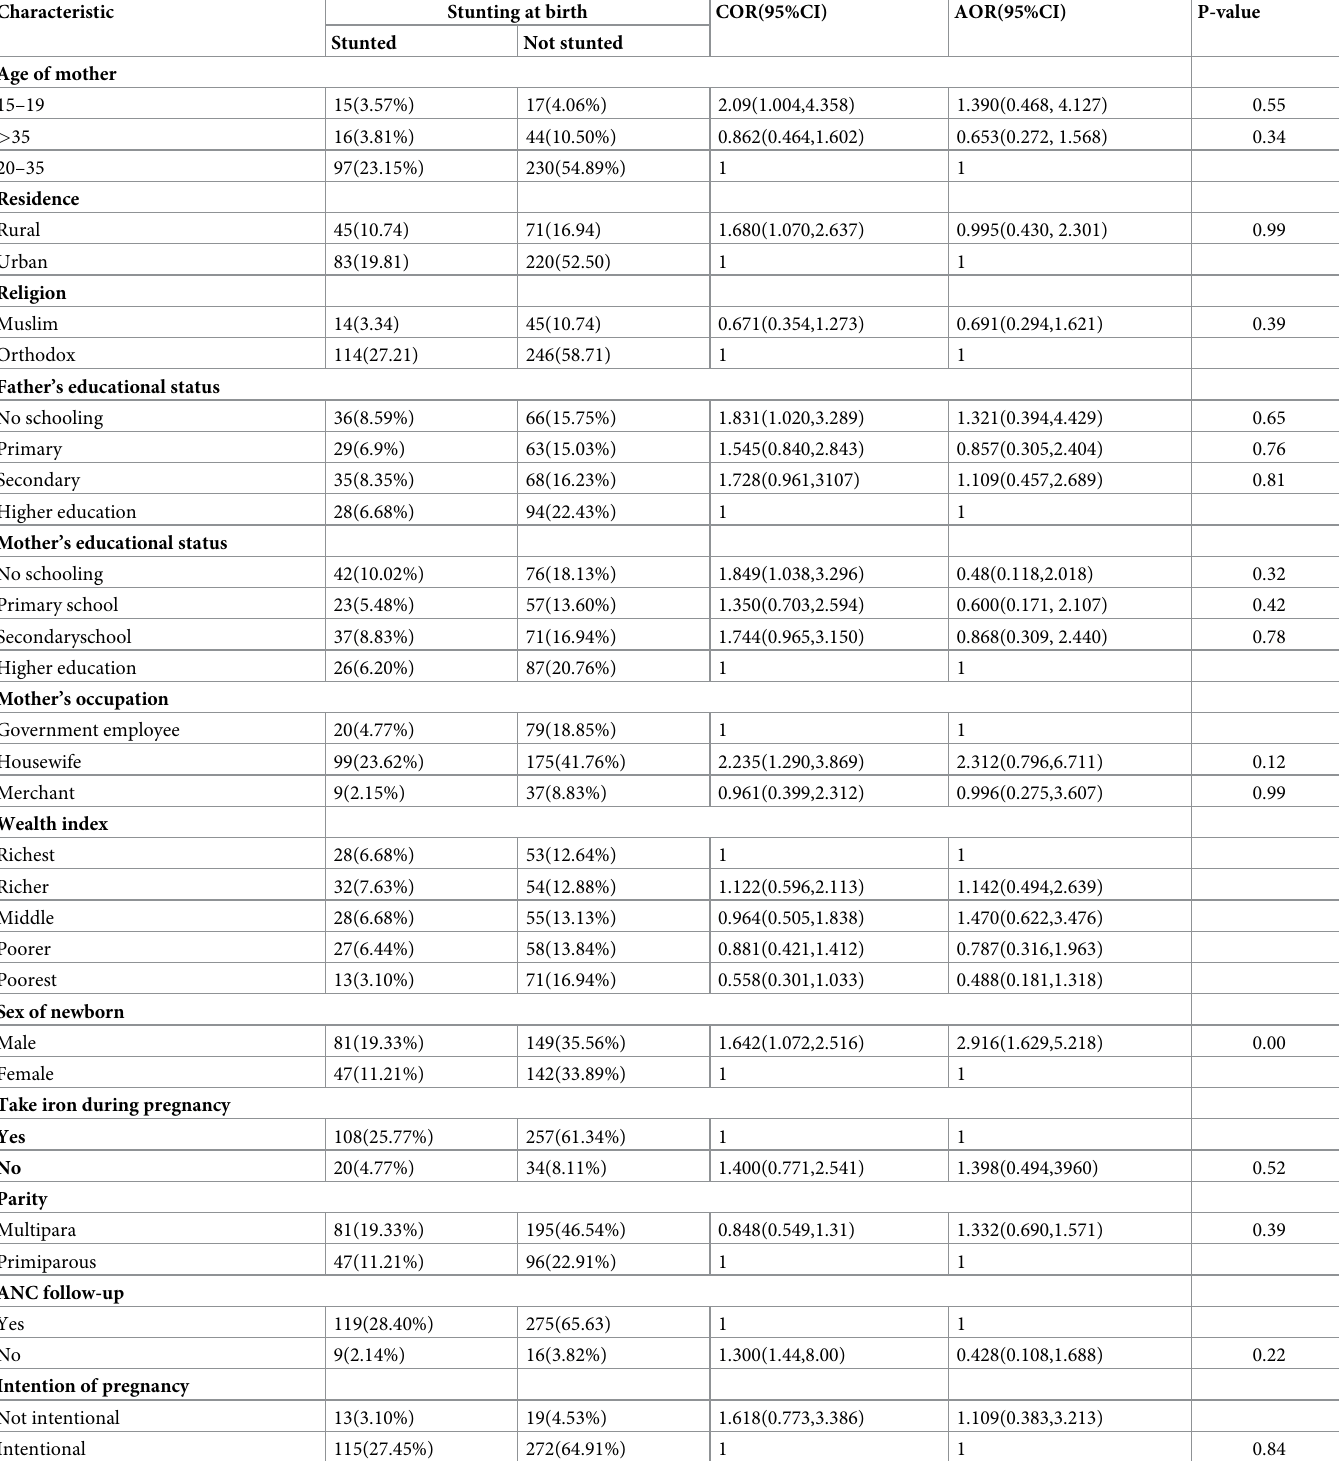
Table 3. Bivariable and multivariable logistic regression output, showing that factors associated with stunting at birth among newborns in Gondar Comprehensive Specialized Referral Hospital, Northwest Ethiopia.